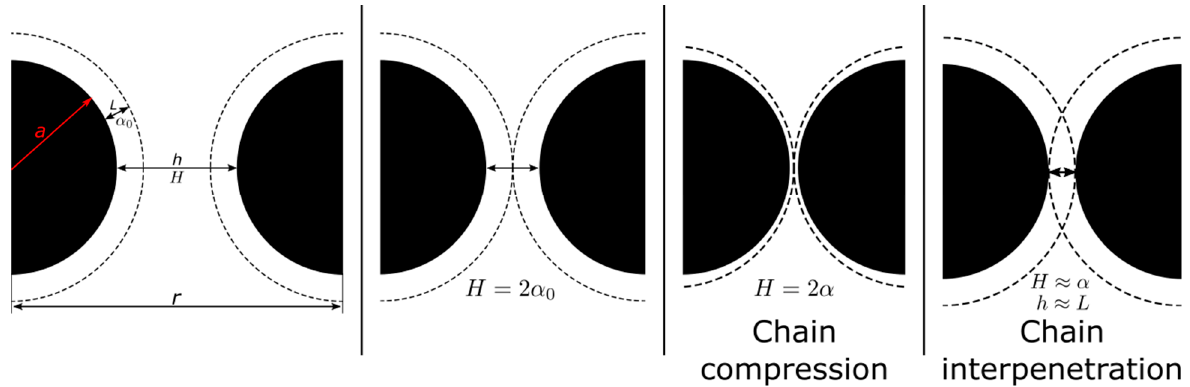
Figure 4. System diagram of sterically stabilized MGNS particles for interparticle energetic potential model.